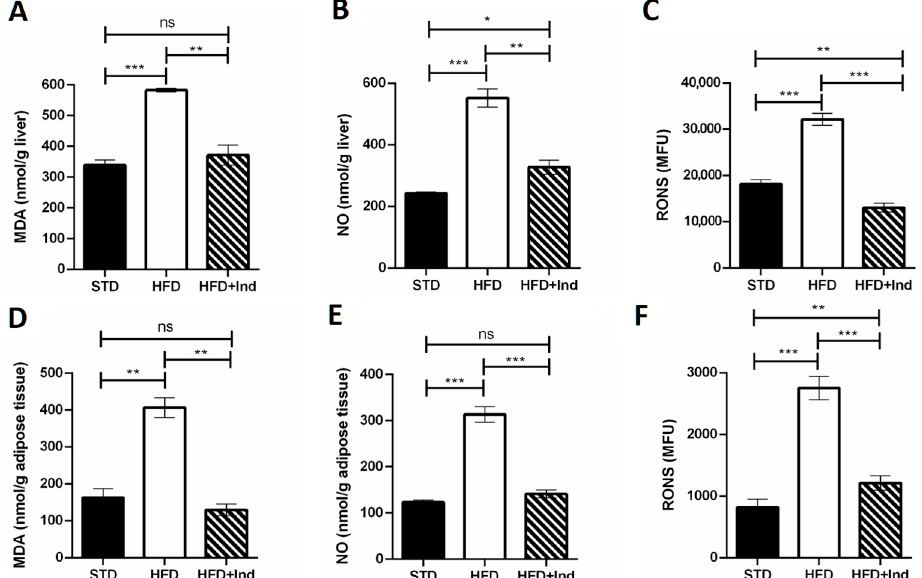
Figure 5. Indicaxanthin treatment prevents oxidative stress in HFD-fed mice. Levels of hepatic ( A – C ) and adipose tissue ( D – F ) MDA, NO and RONS, respectively. Results are shown as means ± SEM of 8 animals/group. ns: p > 0.05; * p ≤ 0.05; ** p ≤ 0.01; *** p ≤ 0.001 (ANOVA associated with Bonferroni’s correction).